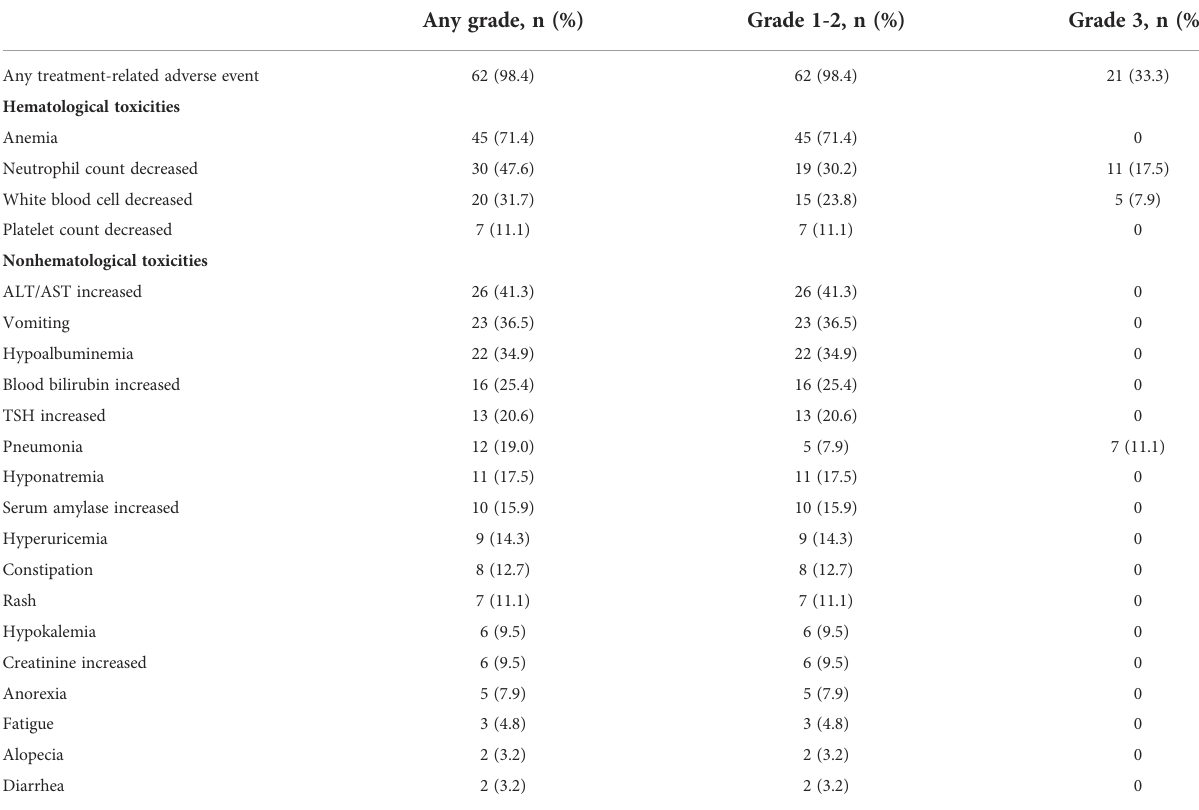
TABLE 4 Treatment-related adverse events during neoadjuvant treatment (n=63). Any grade, n (%) Grade 1-2, n